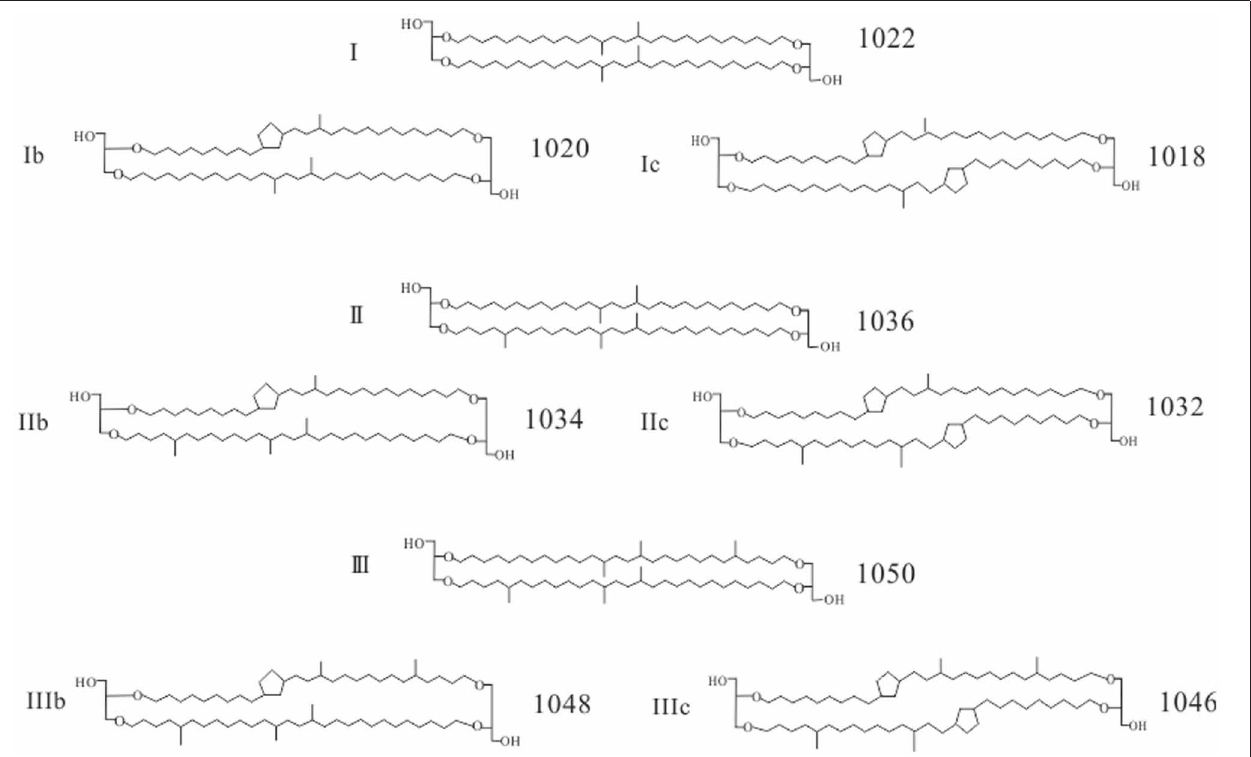
FIGURE A1 | Schematic structures of core branched glycerol dialkyl glycerol tetraethers (bGDGTs).